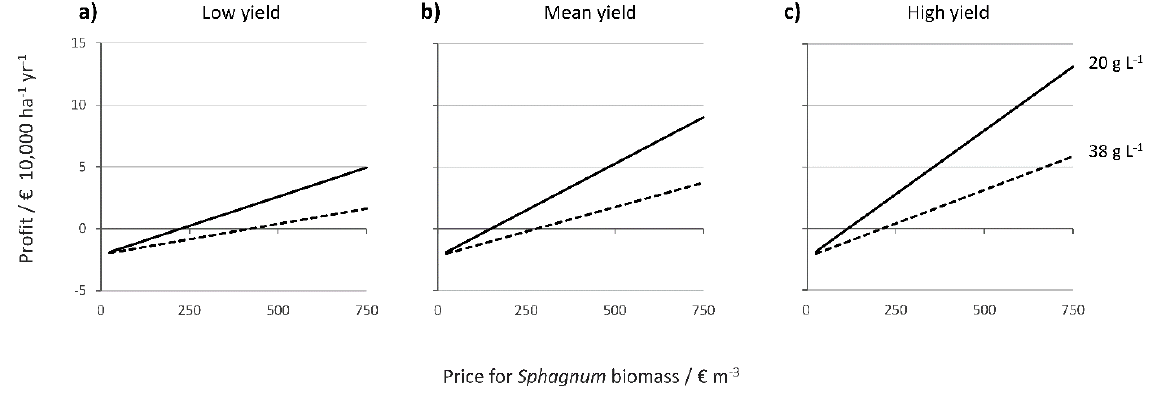
Figure 8. Profitability of Sphagnum farming given as Annuity ( T = 20 years; r = 3 %) for Cost Scenario A according to the average dry mass yield (low, mean or high; 2.0, 3.2 or 4.4 t ha -1 yr -1 ), the conversion factor for bulk density (solid line: 20 g L -1 ; dashed line: 38 g L -1 ) and the price level (range € 25 to € 750 m -3